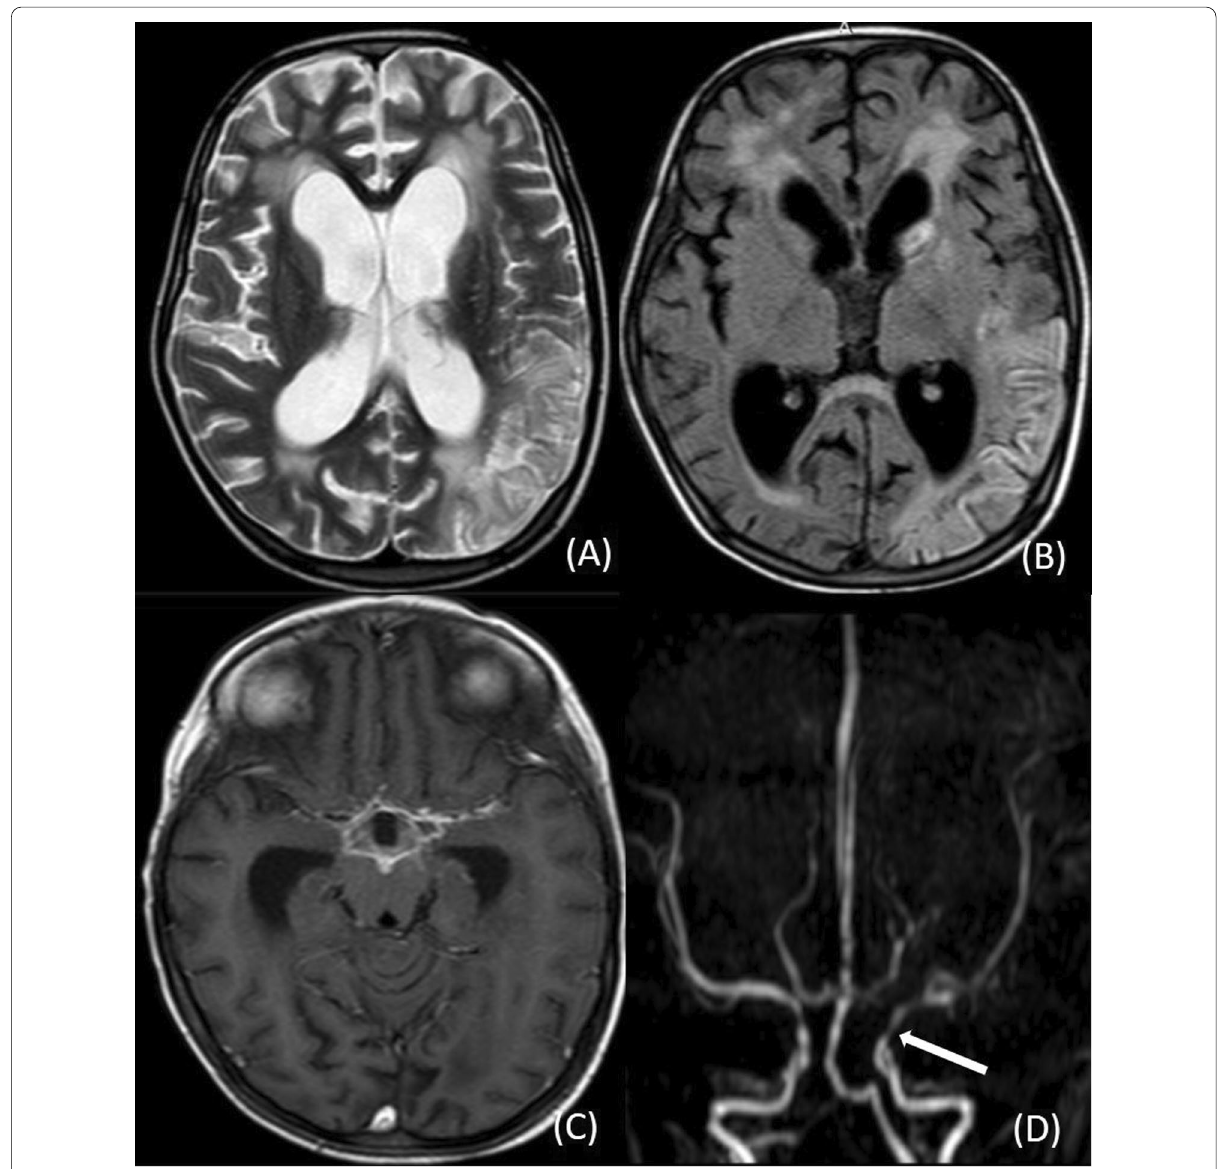
Fig. 2 CNS TB with moyamoya vasculopathy and infarction in left MCA territory. MRI of a 5-year-old girl shows hyperintensity involving both grey and white matter in left MCA territory on T2W ( A ) and FLAIR image ( B ) with communicating hydrocephalus ( A and B ), T1 contrast-enhanced image shows exudates in basal cistern and left sylvian fissure ( C ), MR angiography shows attenuated supraclinoid segment of left ICA and left MCA (white arrow in D